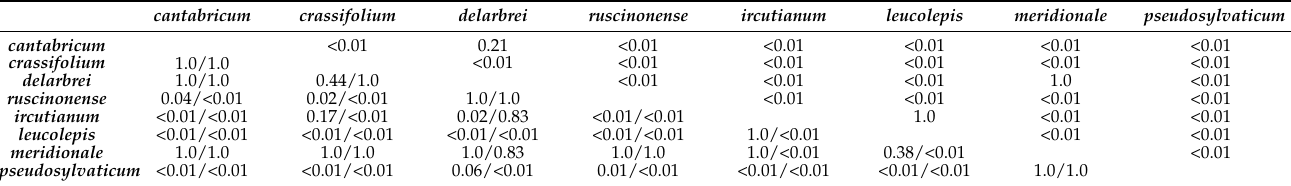
Table 1. Bonferroni-corrected p -values for pairwise tests of morphological similarity. The upper triangle represents p -values of the LDI-based Welch’s tests, determining divergence in the dissection of the leaves. The lower triangle comprises p -values of the permutation tests of Euclidean distances in PC space (left) and NPMANOVA results (right), quantifying differences in general leaf shape. Corrected p -values are truncated to 1.0.